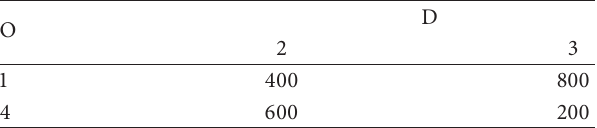
Table 1: Travel demands of each OD pair